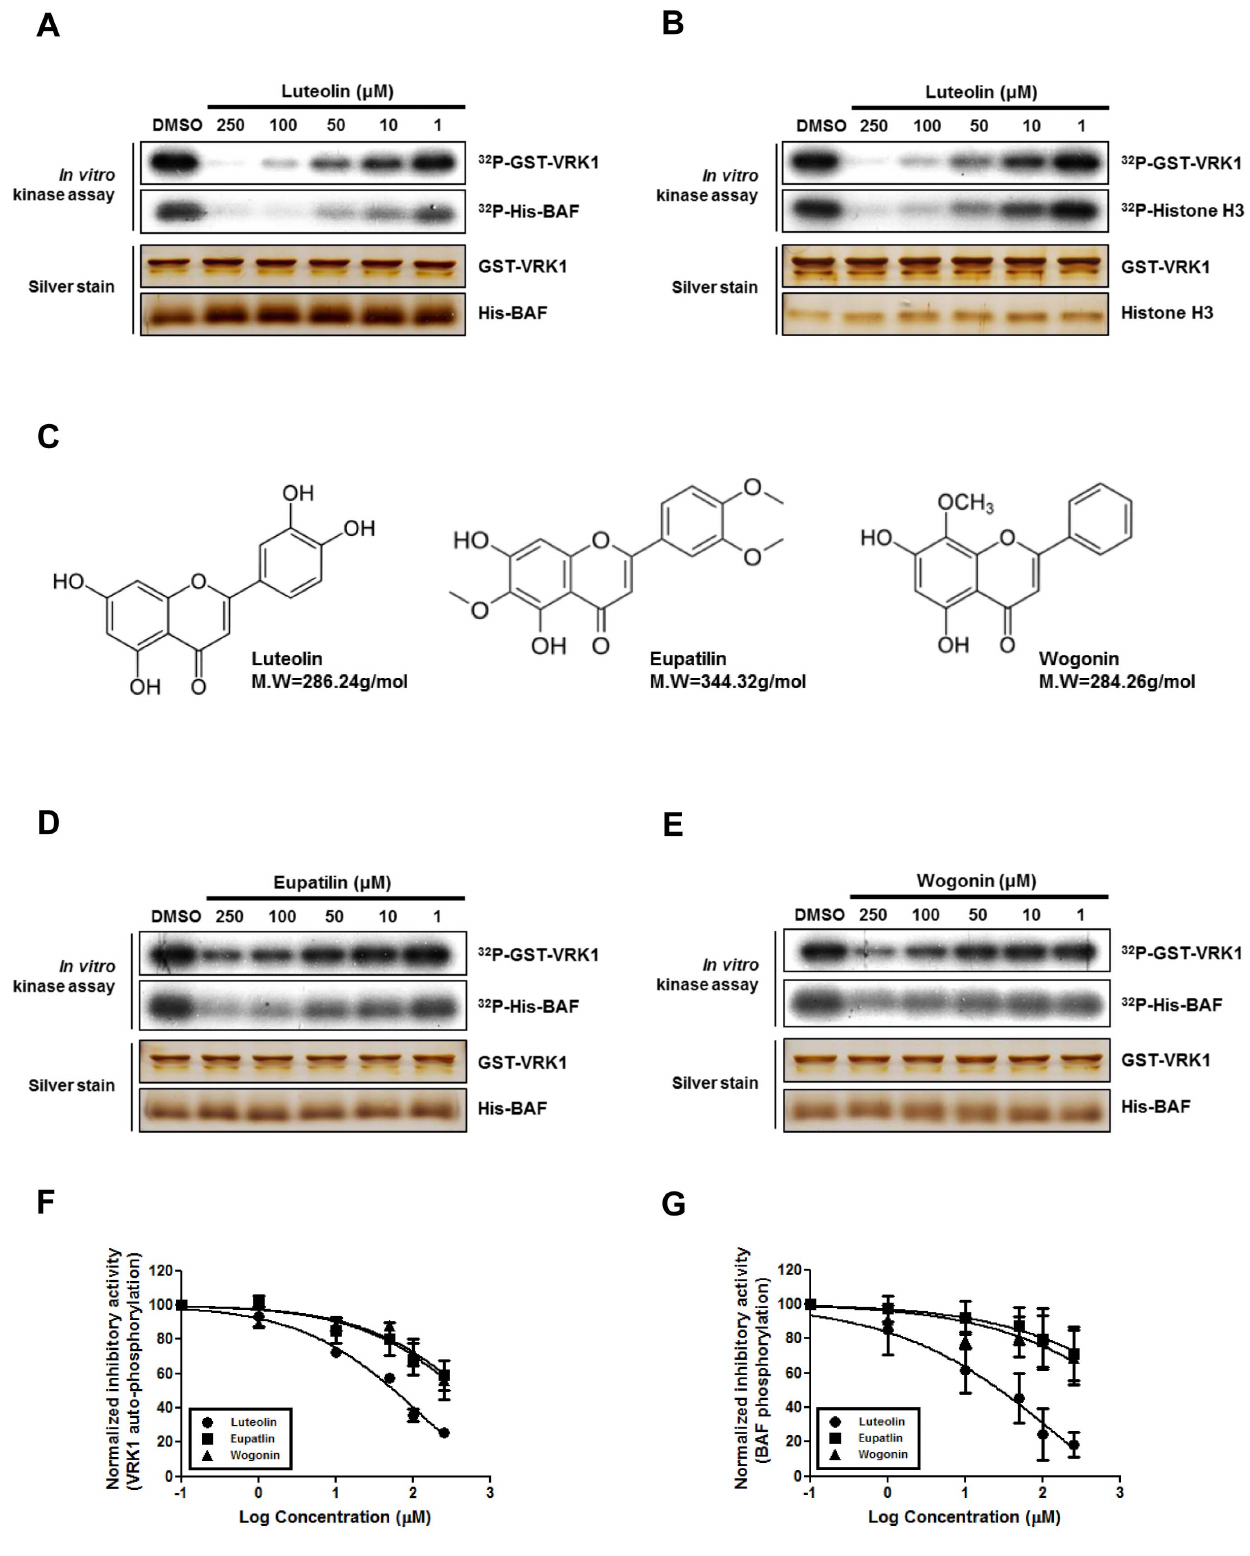
Figure 1. Inhibitory effects of luteolin on VRK1 kinase activity. (A) and (B), in vitro kinase activity measurements for VRK1 with BAF (A) or VRK1 with histone H3 (B) were performed by increasing concentrations of luteolin (0.0, 1.0, 10, 50, 100, and 250 m M), and then VRK1 and substrate proteins were stained with silver nitrate. (C), Chemical structures and molecular weights of luteolin, eupatilin, and wogonin. (D) and (E), in vitro kinase assay for VRK1 with BAF were performed by increasing concentrations (0.0, 1.0, 10, 50, 100, and 250 m M) of eupatilin (D) or wogonin (E), and then VRK1 and BAF proteins were stained with silver nitrate. (F) and (G), Quantification of VRK1 auto-phosphorylation (F) or BAF phosphorylation (G) described in (B), (D) and (E). Data in (F) and (G) represent means of three independent experiments 6 SEMs. doi:10.1371/journal.pone.0109655.g001 PLOS ONE |